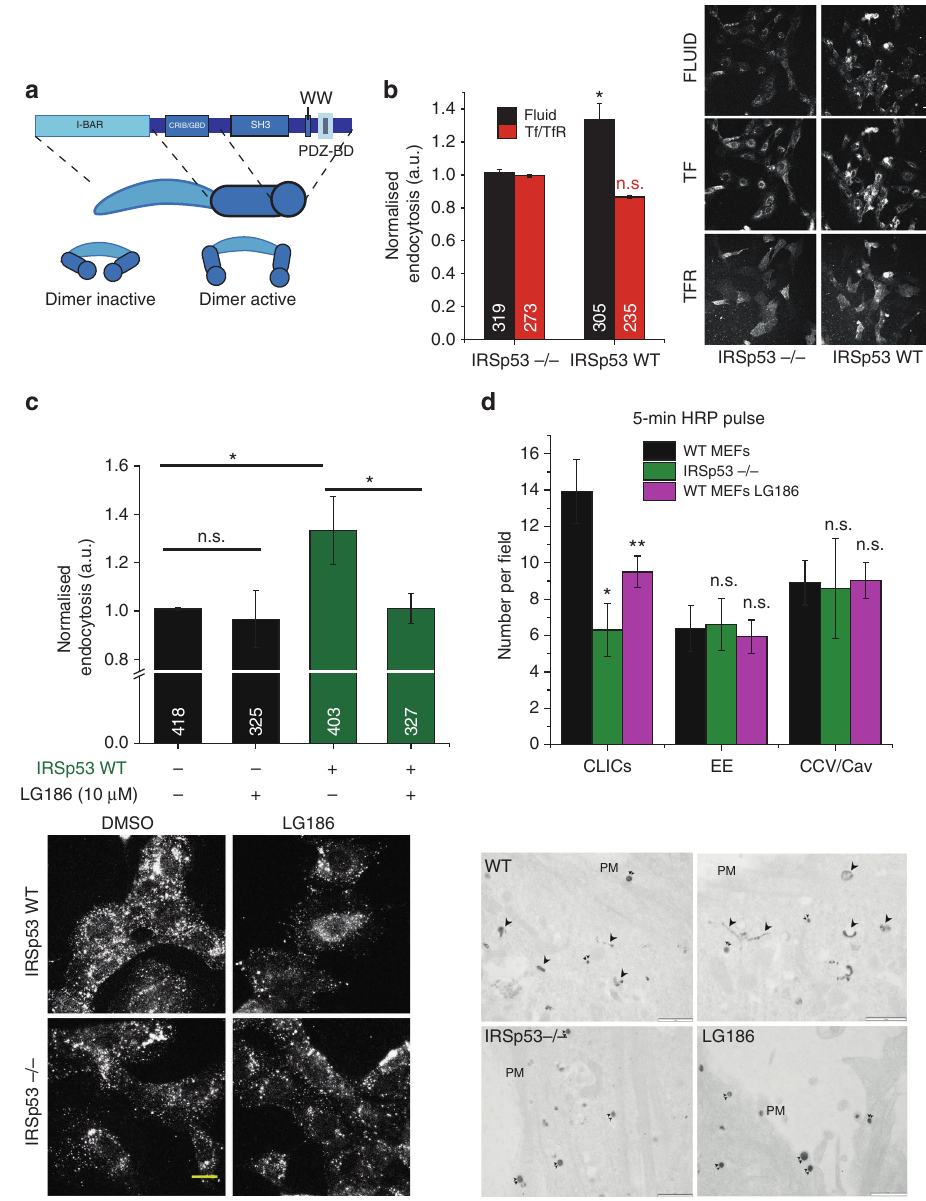
Fig. 3 IRSp53 is involved in CG endocytosis. a Schematic depicting the domain organisation of IRSp53. IRSp53 exists in an inactive dimer state, which upon binding to GTP-CDC42 is activated, allowing SH3 domain to bind to its effectors. b Histogram (left) shows 5-min uptake of TfR and fl uid phase in IRSp53 WT cells normalised to IRSp53 − / − cells, along with representative images (right). Data were pooled from two independent experiments and the number of cells indicated in the fi gure. c Histogram (top) shows normalised 5-min fl uid uptake in IRSp53 − / − and IRSp53WT cells when treated with LG186 or vehicle (DMSO) along with representative images (bottom). Data were pooled from two independent experiments and the number of cells indicated in the fi gure. d Histogram (top) shows an average number of endocytic structures quanti fi ed per fi eld from the electron microscope images (bottom). Data pooled from three independent blocks. Untreated WT MEFs (WT, top row), IRSp53 null MEFs (IRSp53 − / − , bottom left) or LG186-treated WT MEFs (LG186, bottom right) were incubated for 5 min at 37 °C with 10 mg/ml HRP as a fl uid-phase marker before processing for electron microscopy. Endocytic structures close to the plasma membrane (PM) are fi lled with the electron dense peroxidase precipitate. WT cells show a range of endocytic structures including vesicular structures (double arrowheads) and tubular/ring-shaped putative CLIC/GEECs (large arrowheads) but the IRSp53 − / − cells and LG186- treated cells only show predominant labelling of vesicular pro fi les. p value <0.05 (*), 0.001 (**) Mann – Whitney U test ( b – c ) and two-sample Student ’ s t test ( d ). Error bars, s.d. ( b – d ). Scale bar, 20 µ m ( b – c ), 1 µ m ( d ), respectively. Schematic ( a ) was adapted with permission from MBInfo